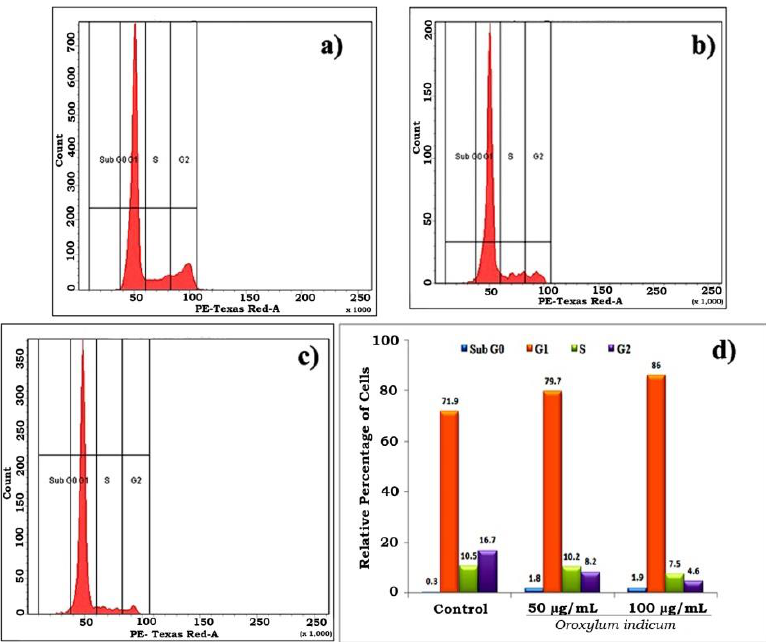
Figure 3. Flow cytometric analysis showing cell cycle stages in ( a ) untreated HeLa cells, ( b , c ) HeLa cells treated with OIM 50 and 100 µg/mL, respectively, and ( d ) a relative percentage of cells at various phases of cell cycle.